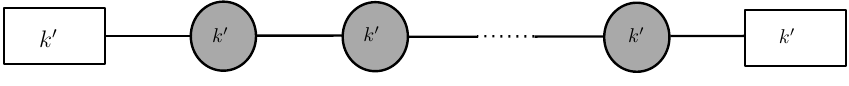
Figure 2 . 6d quiver CFT dual to the AdS 7 / Z k solution to massless Type